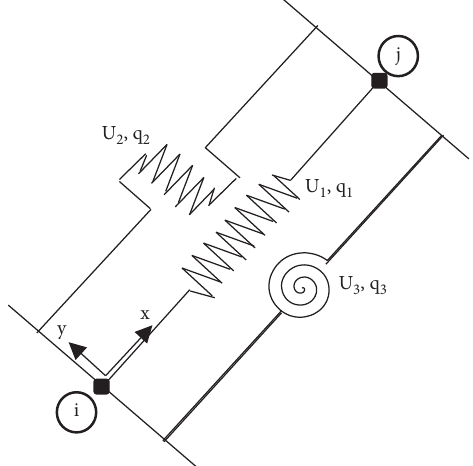
Figure 9: Schematic diagram of twoNodeLink